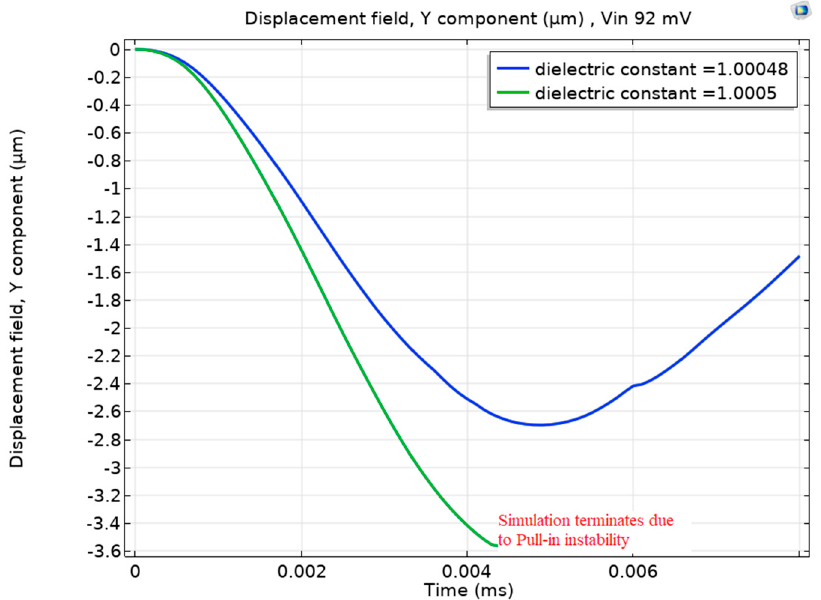
Figure 6. The detection of 5% helium ( ε r = 1.00048) at 3.8 MHz (while the pull-in event happened at 0% helium ( ε r = 1.0005) condition). Table 2. The effect of excitation frequency on helium detection level and input voltage.